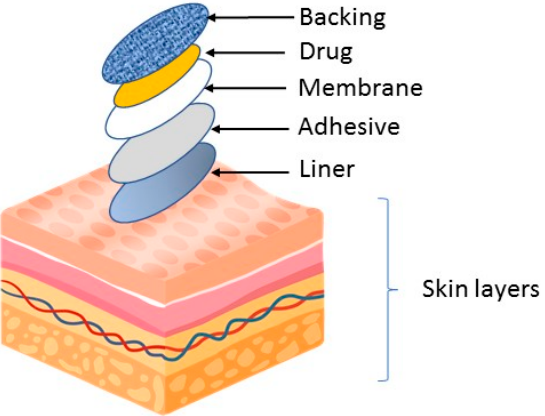
Figure 1. Basic component of a transdermal medical patch.